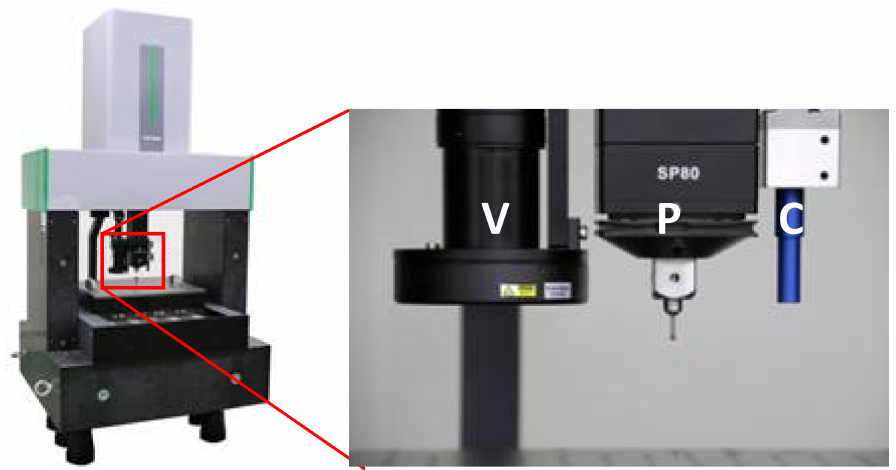
Figure 1. Multi-sensor high-precision coordinate measuring machine (CMM): V for video camera (VC), P for tactile probe (TP), C for chromatic confocal displacement sensor